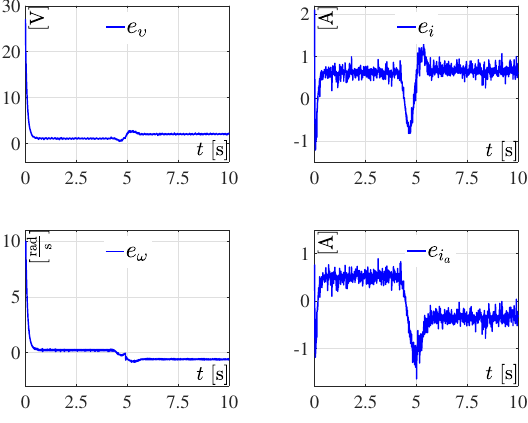
Figure 10. Tracking errors related to experiment